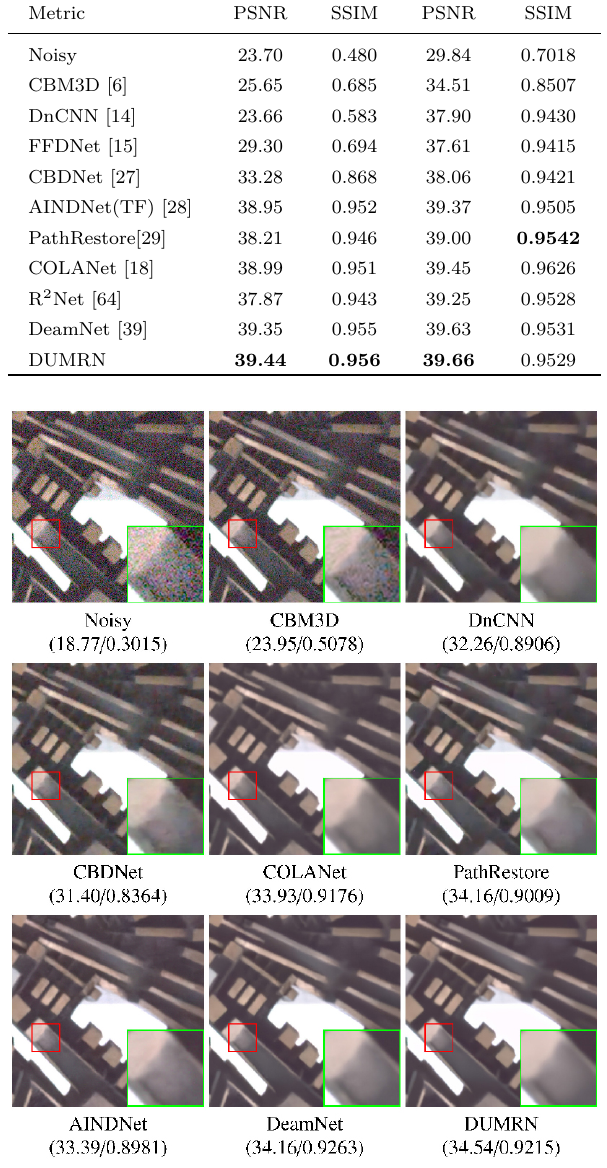
Fig. 7 Real image denoising results of different methods on the image from DnD